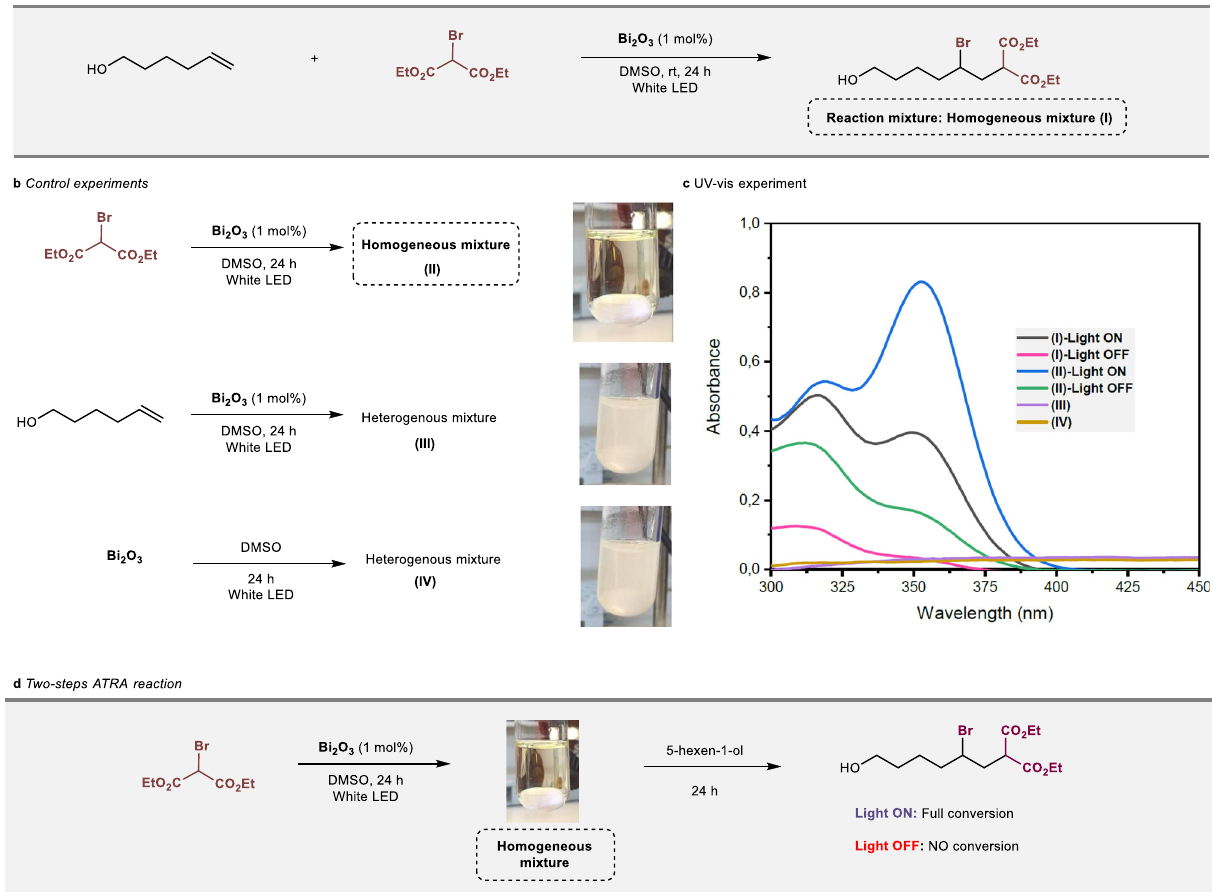
Fig. 2 ATRA reaction photo-induced by Bi 2 O 3 . a Reaction model. b Behavior of the Bi 2 O 3 with substrates and solvent. c UV – vis absorption spectra of the reaction mixtures. The indices used in the plot are de fi ned in ( a , b ). d Light, and dark experiments for the ATRA reaction carried out in two steps. Reaction